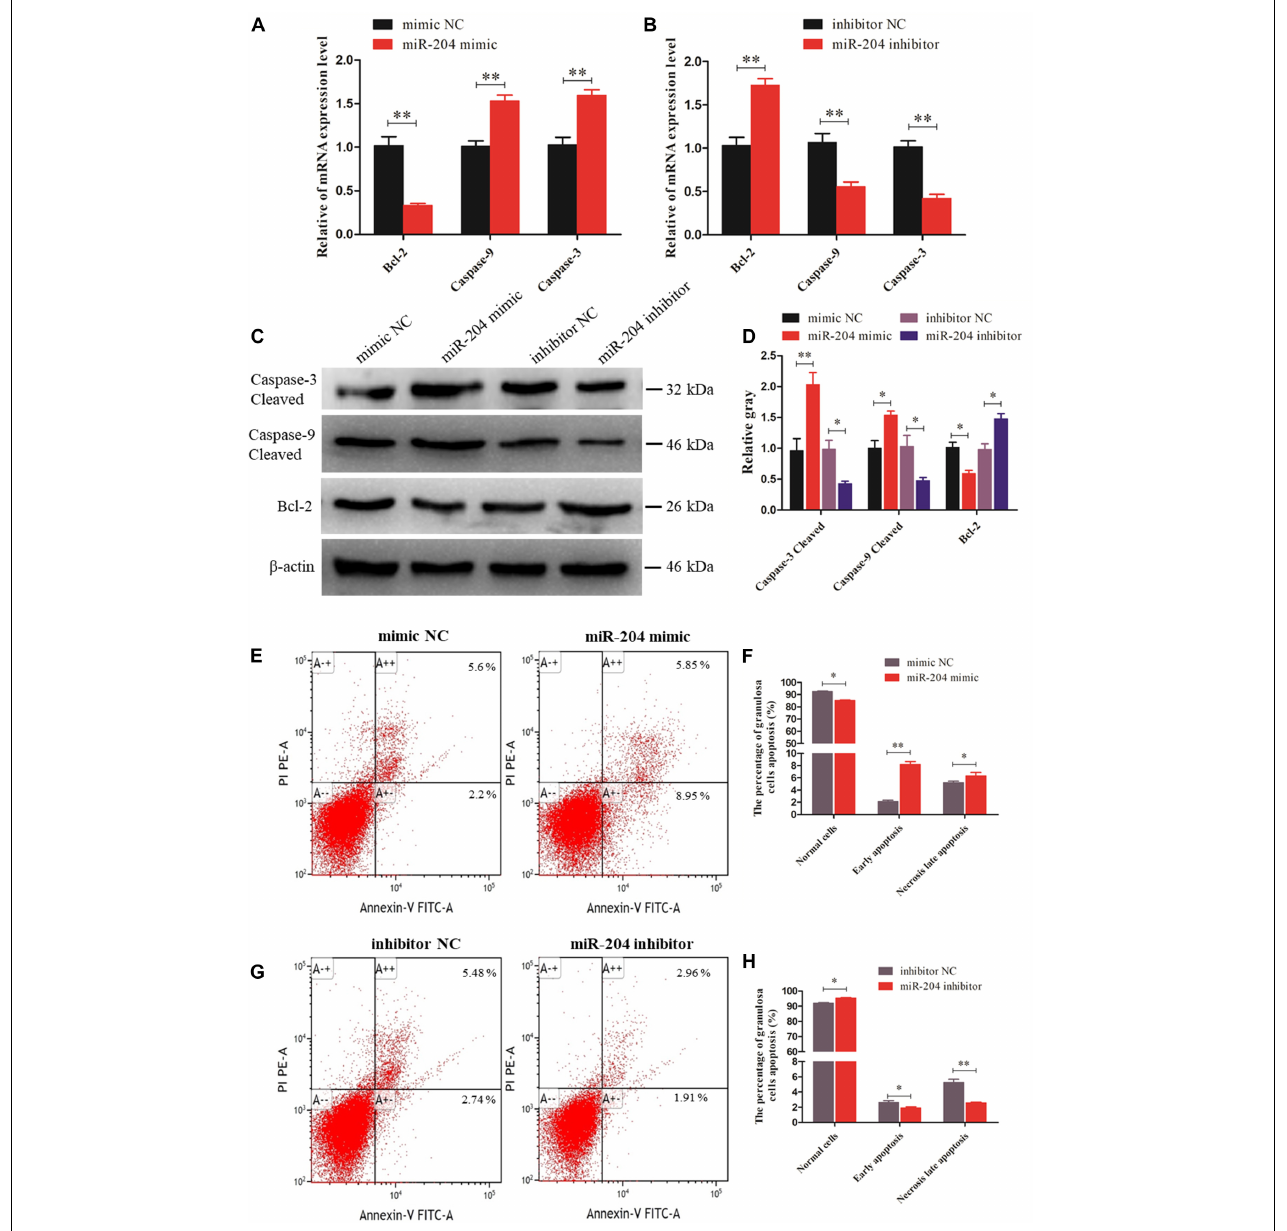
FIGURE 3 | miR-204 regulates the apoptosis of chicken granulosa cells (GCs). (A, B) Expression abundances of cell apoptosis-related genes ( Bcl-2 , Caspase-9 , and Caspase-3 ) were detected by quantitative real-time PCR (qRT-PCR) after overexpression and inhibition of miR-204, respectively. (C, D) The Western blot analysis revealed caspase-3 and caspase-9 cleavage and protein expression of Bcl-2 after a gain or loss of miR-204. β -actin was used as a reference gene. (E) Apoptotic GCs were detected by annexin V-fluorescein isothiocyanate (FITC)/propidium iodide (PI) staining flow cytometry after overexpression of miR-204. (F) The percentages of GC apoptosis were measured after overexpression of miR-204. (G) Apoptotic GCs were detected by annexin V-FITC/PI staining flow cytometry being inhibited by miR-204. (H) The percentages of GC apoptosis were determined after inhibition of miR-204. Replications = 3. Data are presented as mean ± SE; * P < 0.05 and ** P < 0.01. NC, negative